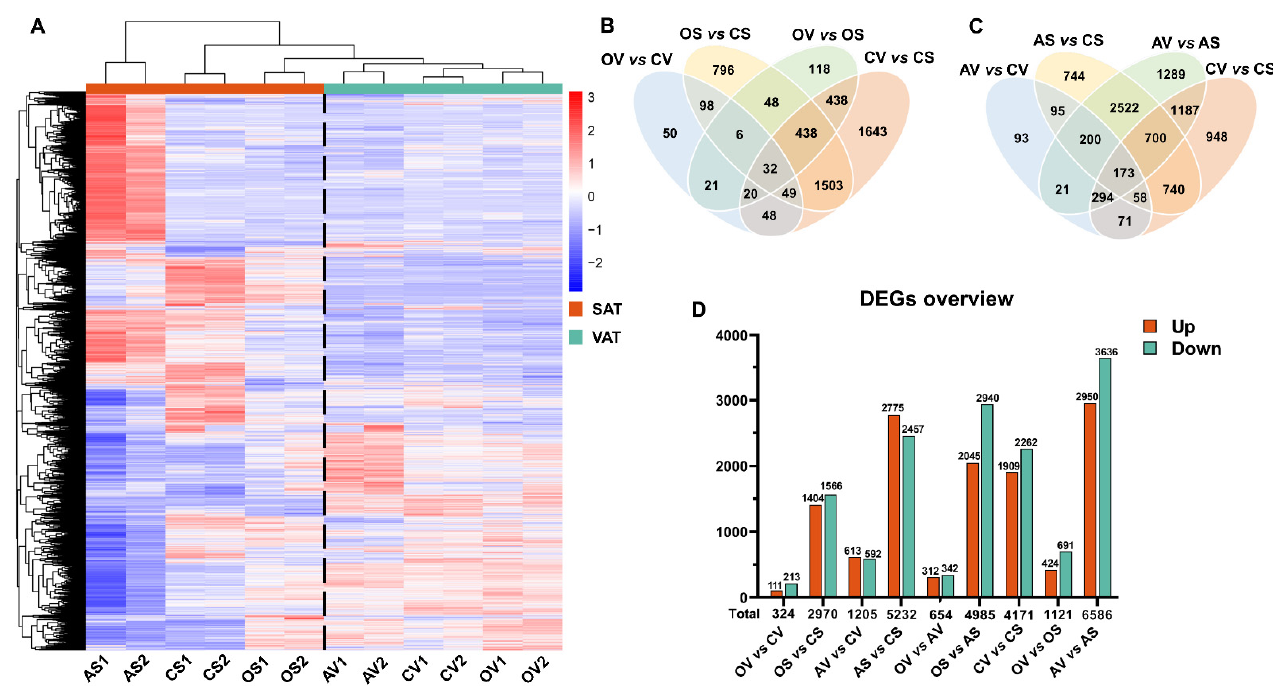
Figure 2. Distinct transcriptomic response of AT to OVX versus ADX in female mice. ( A ) Hierarchical clustering analysis of the differentially expressed genes (DEGs), based on the z-score of their FPKM value. ( B ) Venn diagram of differentially expressed genes between SAT and VAT of OVX and the sham control mice. ( C ) Venn diagram of DEGs between SAT and VAT of ADX and the sham control mice. ( D ) Overview of DEGs among groups. AS: SAT of ADX mice; CS: SAT of the sham control mice; OS: SAT of OVX mice; AV: VAT of ADX mice; CV: VAT of the sham control mice; OV: VAT of OVX mice.